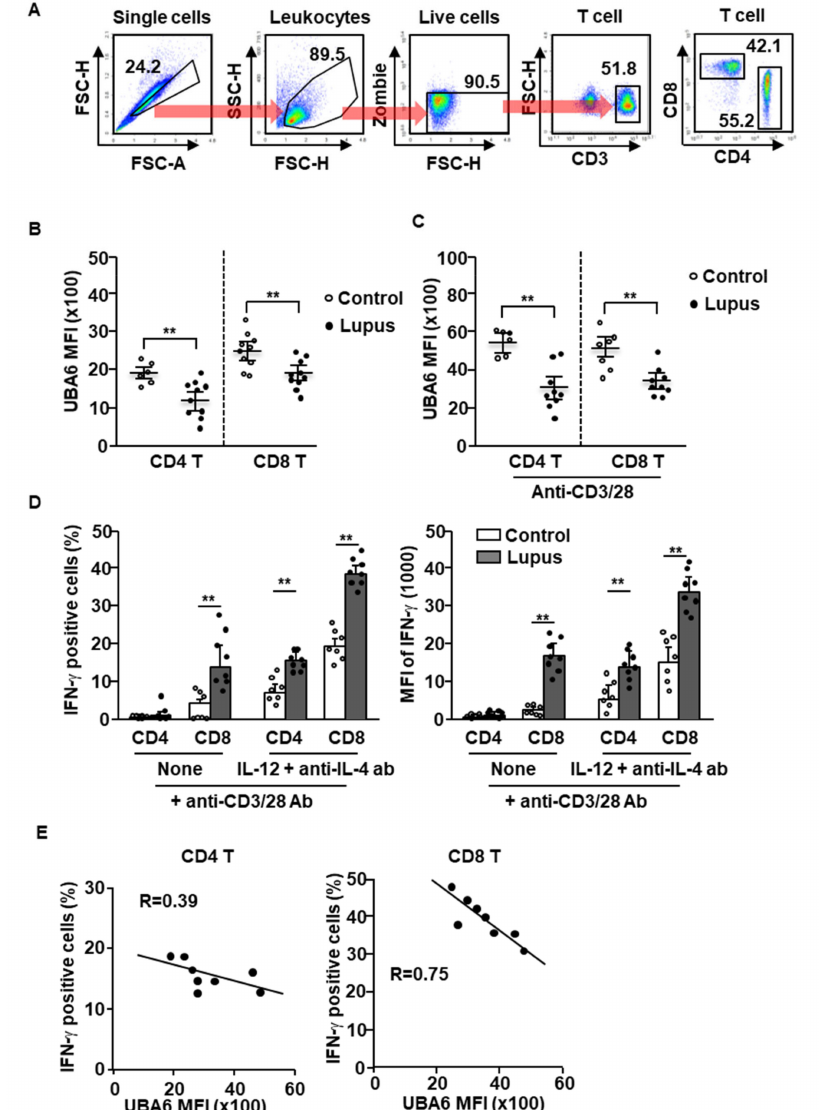
Figure 4. UBA6 negatively regulates IFN- γ production in SLE patient T cells. Peripheral blood mononuclear cells (PBMCs) from healthy and SLE donor analyzed expression levels of UBA6 in CD4 and CD8 T cells. ( A ) Definition of CD4 and CD8 T cells in PBMCs was shown. ( B ) MFI of UBA6 in healthy and SLE donor T cells were analyzed by flow cytometry ( n = 6 to 10, two-way ANOVA, mean ± SEM, ** p < 0.01). ( C ) The isolated CD4 and CD8 T cells were stimulated with anti- CD3/28 and levels of UBA6 in the T cells were measured ( n = 6 to 9, two-way ANOVA, mean ± SEM, ** p < 0.01). ( D ) Intracellular production levels (left panel) and MFI of IFN- γ (right panel) were analyzed in CD4 and CD8 T cells after stimulation with cytokine and mAbs ( n = 7 to 8, two-way ANOVA, mean ± SEM, ** p < 0.01). ( E ) Co-relation of UBA6 expression and IFN- γ -production levels in SLE T cells were